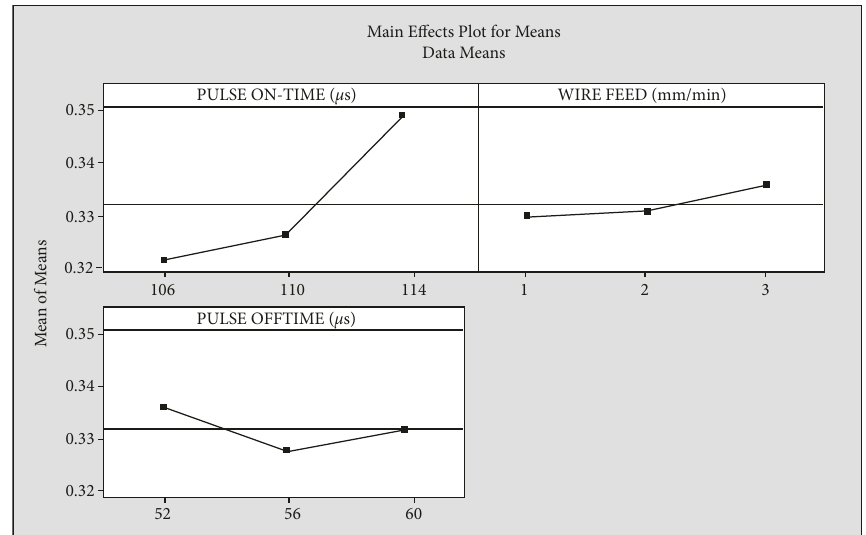
Figure 16: Main effects plot for means.